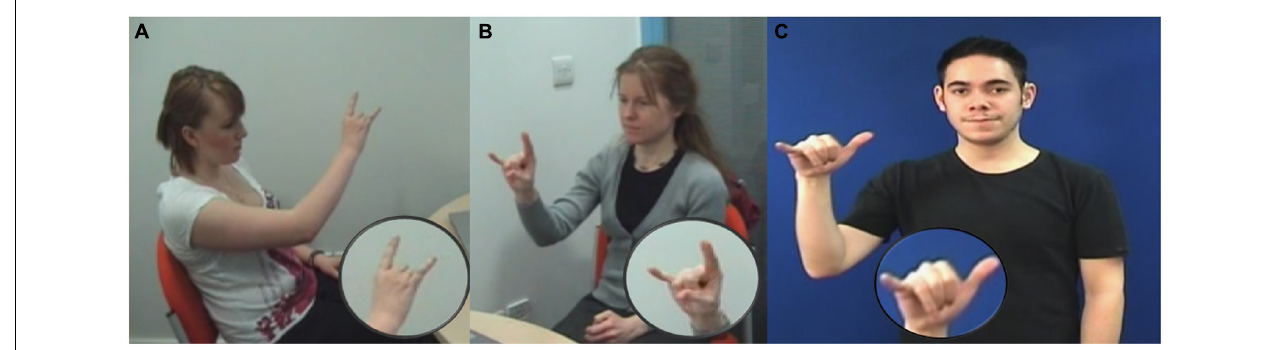
FIGURE 4 | Participants (A,B) attempting to produce the BSL sign PLANE (C) during a sign repetition task. Participants failed to produce the target handshape yet they executed a sign that retained its iconic